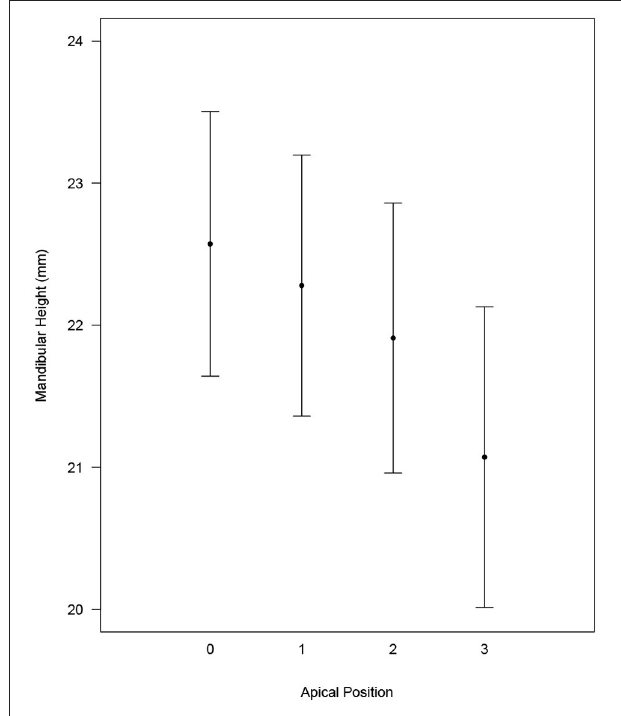
FIGURE 3 | Estimated average mandibular height with CI for each apical position while controlling for multiple measures within each dog and for Side and Root. All two-way comparisons are statistically significant (Tukey p < 0.01) except for 0 vs. 1 (Tukey p = 0.103) and 1 vs. 2 (Tukey p =